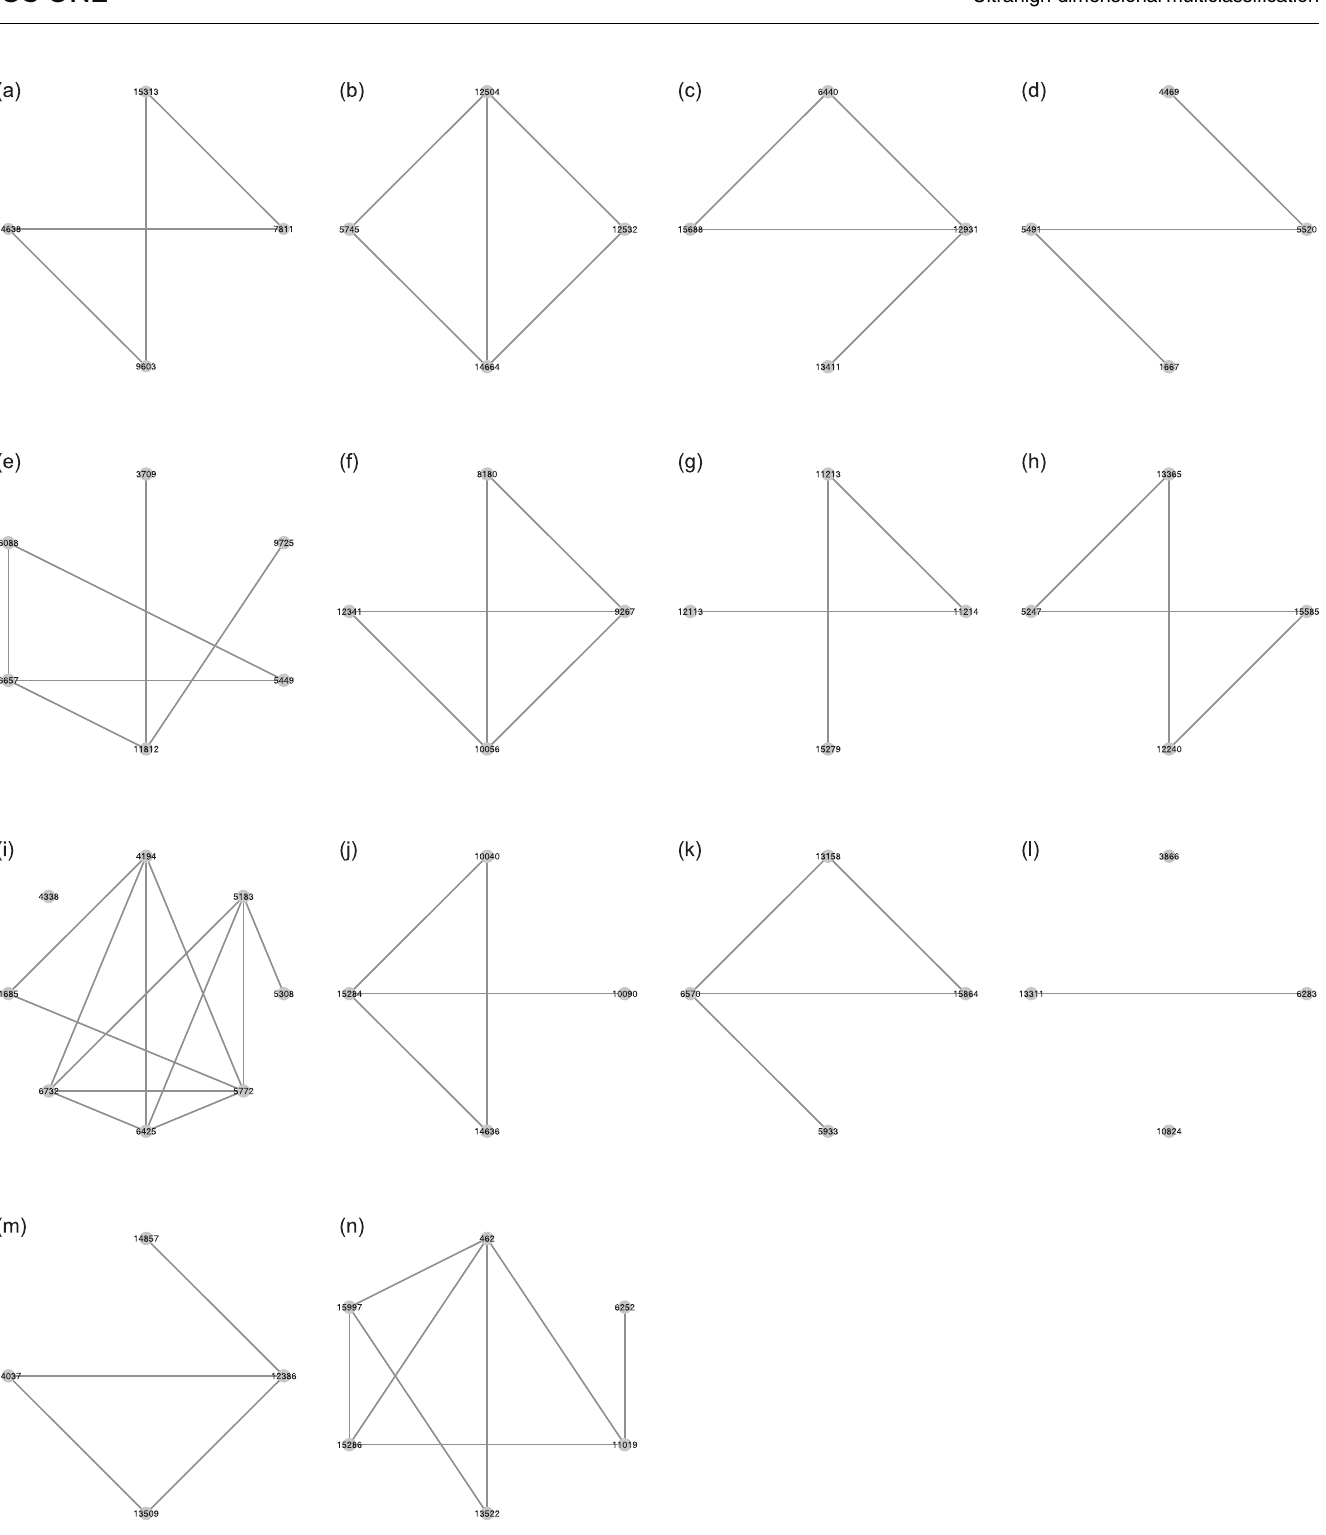
PLOS ONE | https://doi.org/10.1371/journal.pone.0274440 September 15,